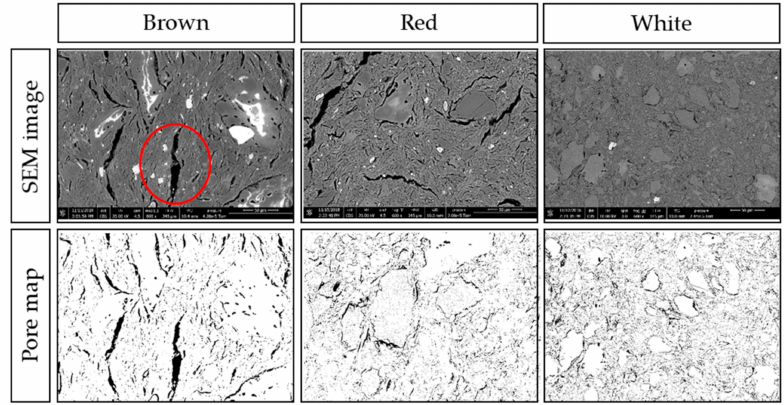
Figure 9. Cross-section SEM micrographs at 600x magnification of brown, white, and red ceramics with the associated pore